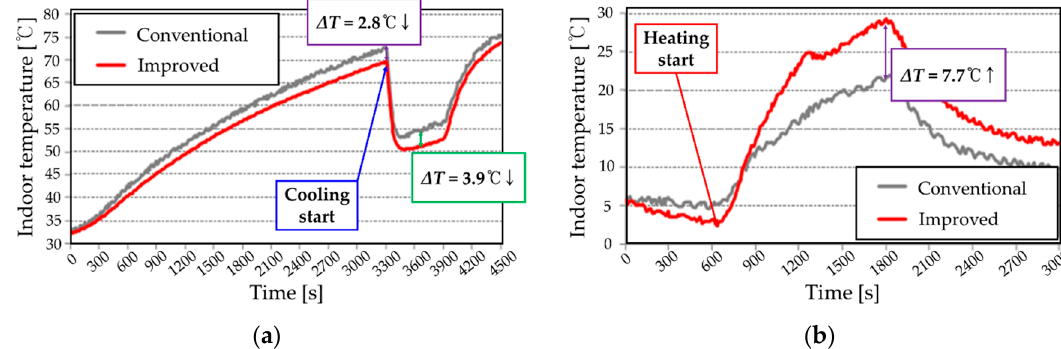
Figure 18. Actual thermal load evaluation results: ( a ) Summer cooling evaluation result (indoor temperature); ( b ) Winter heating evaluation result (indoor temperature).